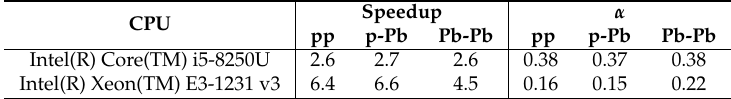
Table 3. The maximum theoretical speedup compared to the single thread and the non-parallelizable part α of the